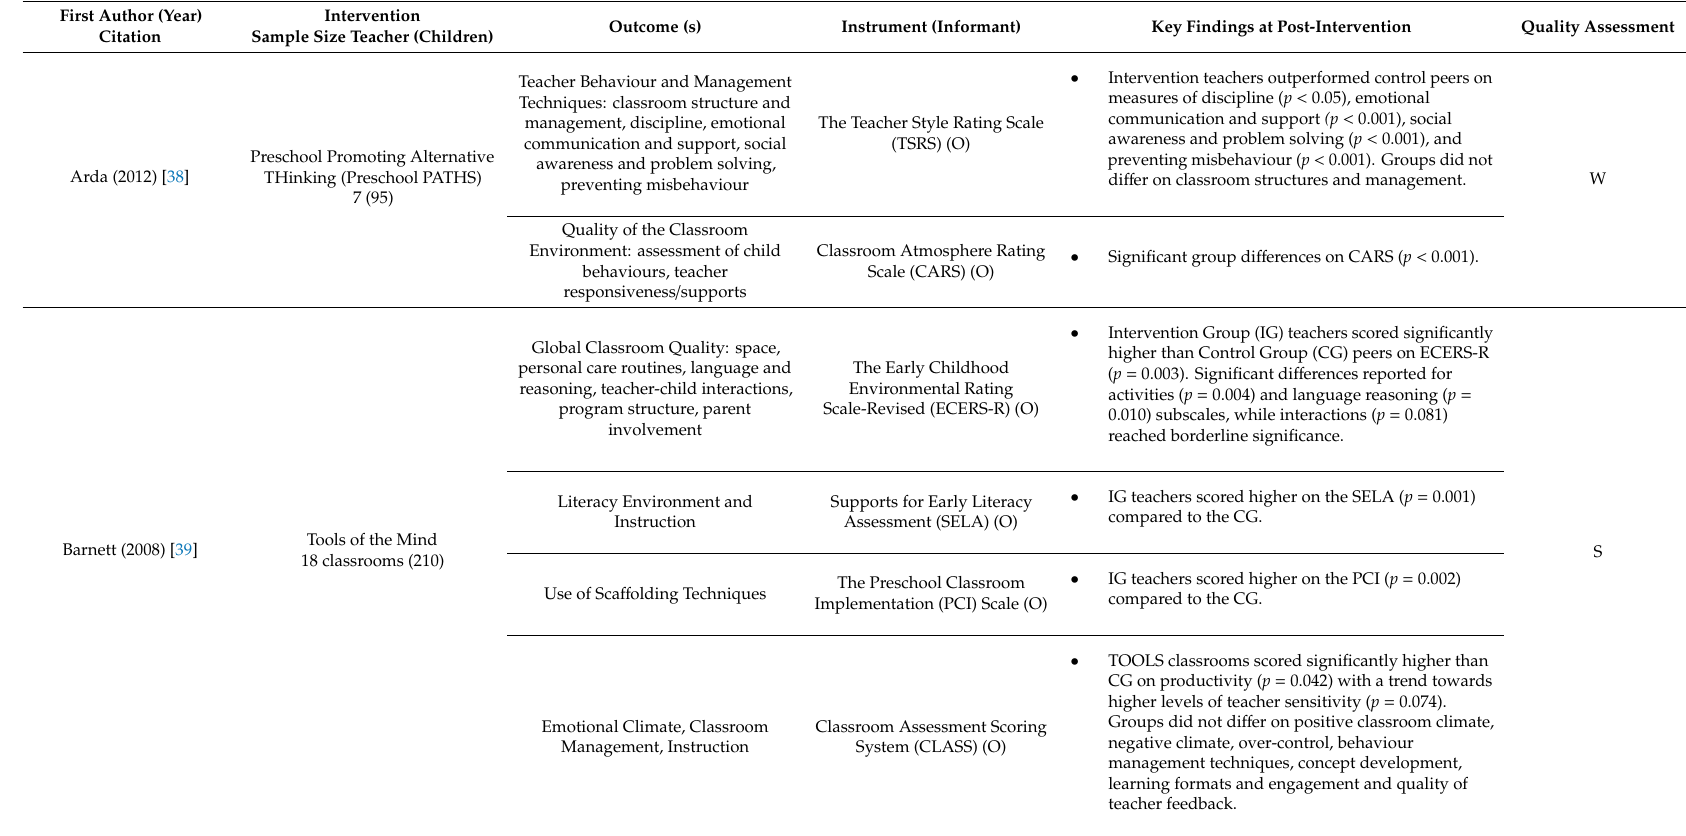
Table 4. Intervention E ff ects on Teacher-Level